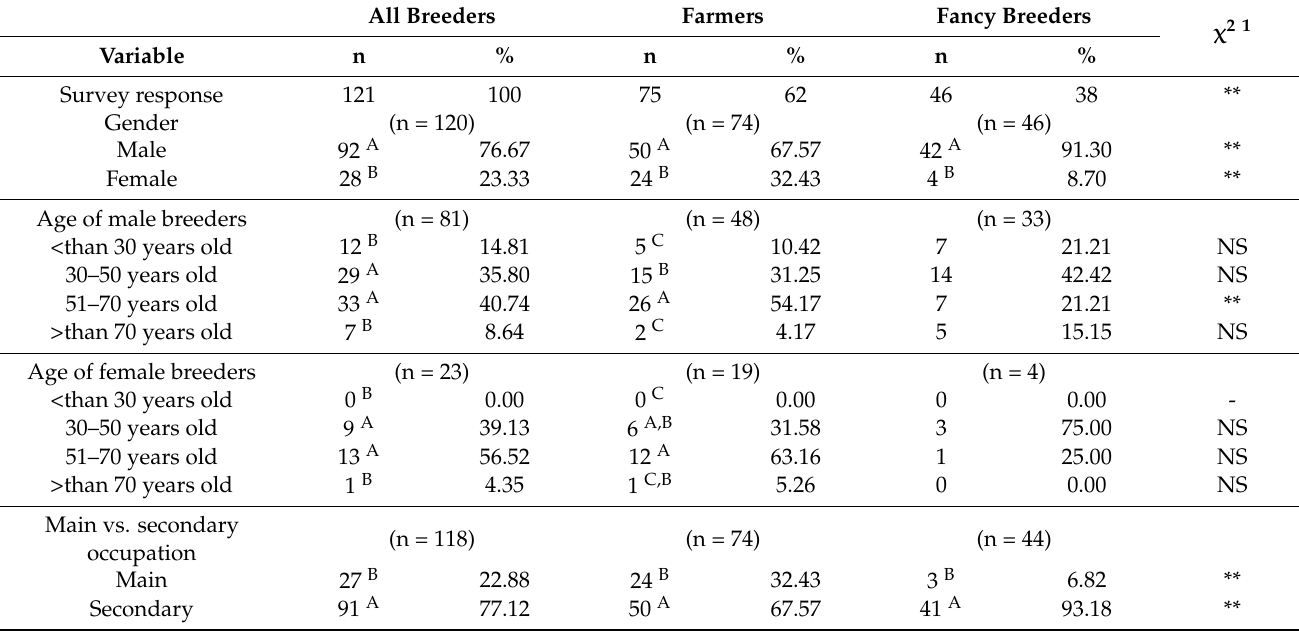
Table 1. Personal information: all breeders surveyed and divided according to breeder category. All Breeders Farmers